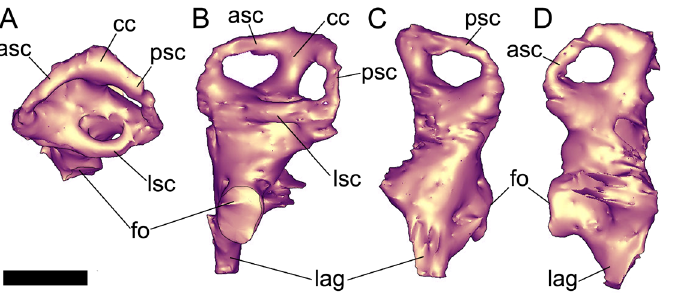
Fig 6. Digital reconstruction of the left inner ear of Pawpawsaurus campbelli (FWMSH93B.00026). In dorsal (A), lateral (B), posterior (C), and anterior (D) views. Abbreviations: asc, anterior semicircular canal; cc, crus communis; fo, fenestra ovalis; lag, lagena; lsc, lateral semicircular canal; psc, posterior semicircular canal. Scale bar equals 10